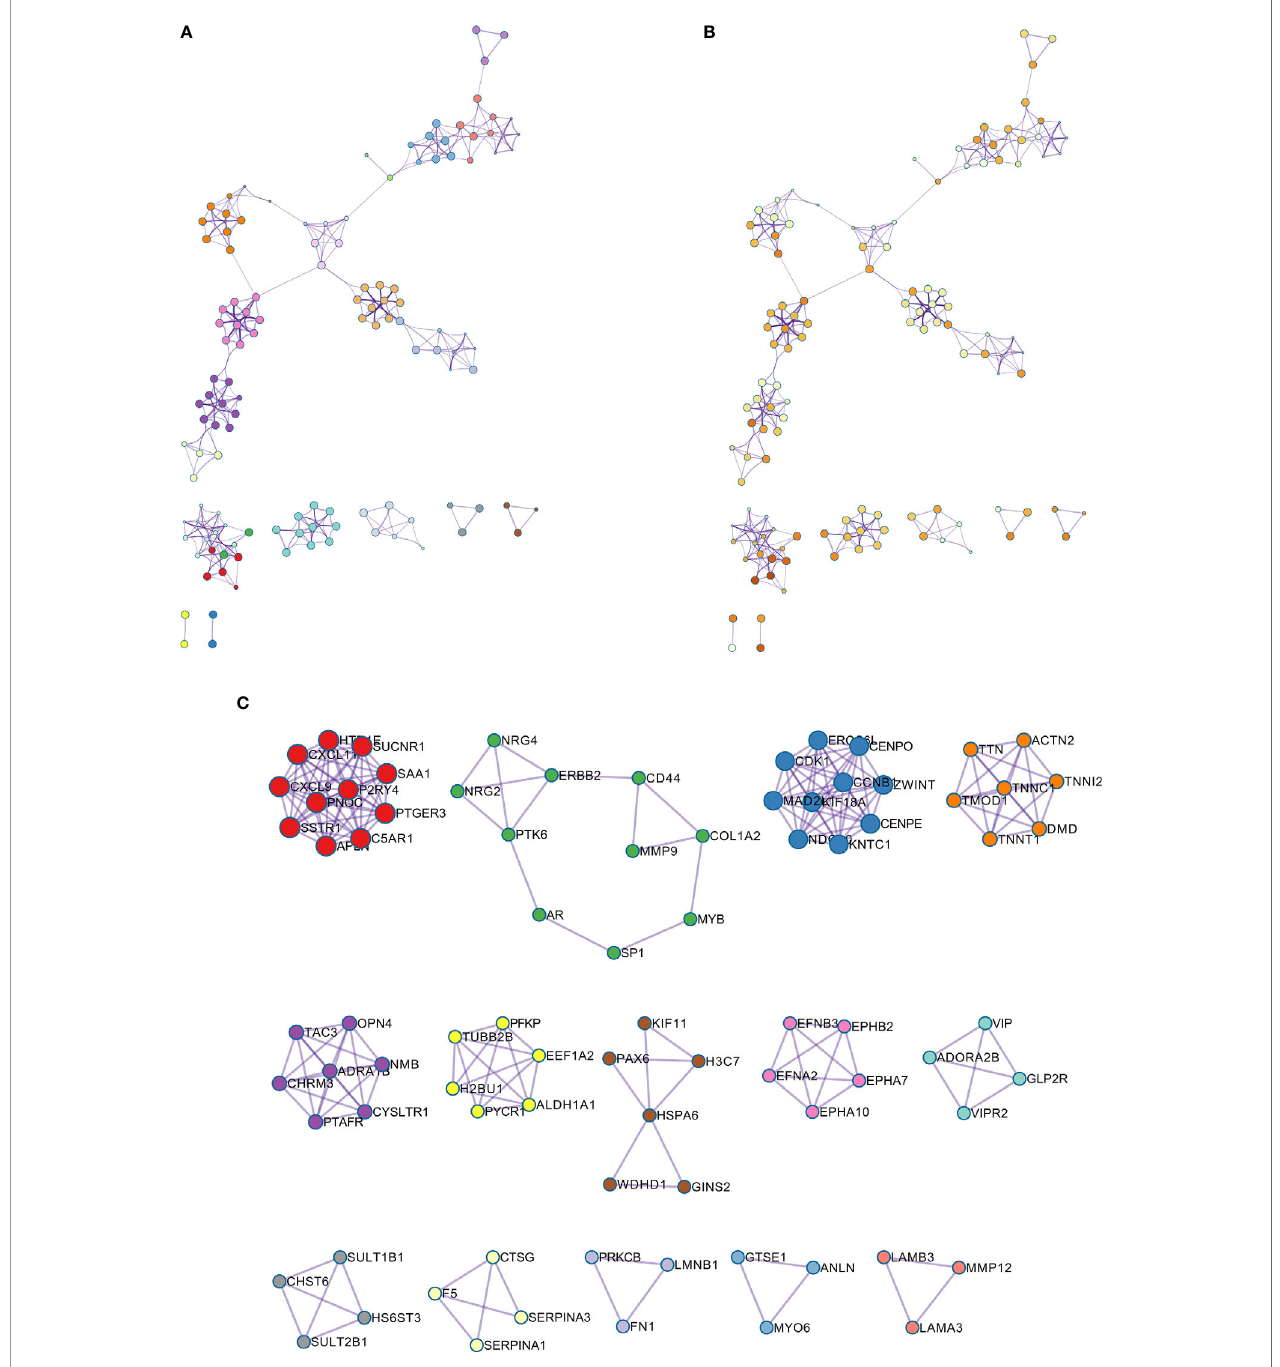
FIGURE 7 | (A) Colored by cluster ID, where nodes that share the same cluster ID are typically close to each other; (B) colored by p-value, where terms containing more genes tend to have a more signi fi cant p-value. (C) Protein-protein interaction network and MCODE components identi fi ed in the gene